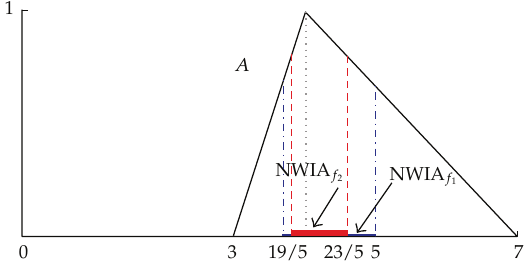
Figure 2: Triangular fuzzy number and its interval approximation.